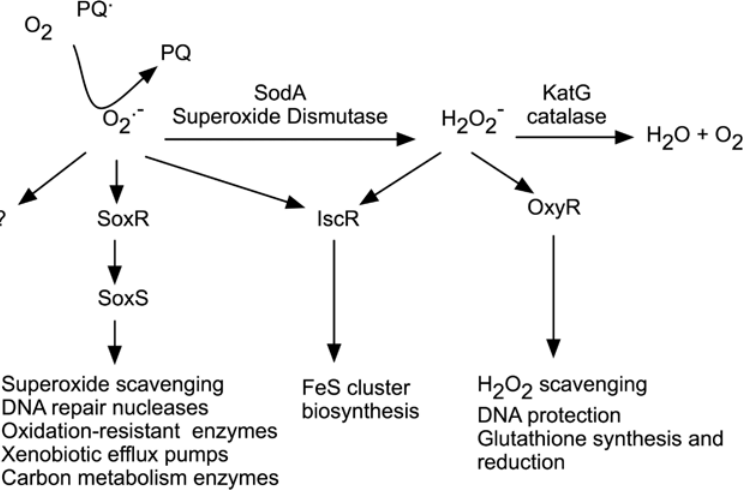
Figure 1. The paraquat-induced transcriptional and metabolic cascade. Paraquat generates superoxide inside the cell by NADPH-mediated reduction of oxygen. Superoxide is sensed by SoxR, which enhances the expression of the transcription factor SoxS, which in turn stimulates other downstream targets. One of the SoxS-regulated genes, sodA (superoxide dismutase), converts superoxide into hydrogen peroxide, which acts as a signal to enhance transcription of genes through OxyR. katG (catalase), a hydrogen peroxide scavenger is an OxyR-regulated gene. Superoxide and hydrogen peroxide also directly affect IscR modulation of a set of genes involved in iron sulfur cluster biogenesis.